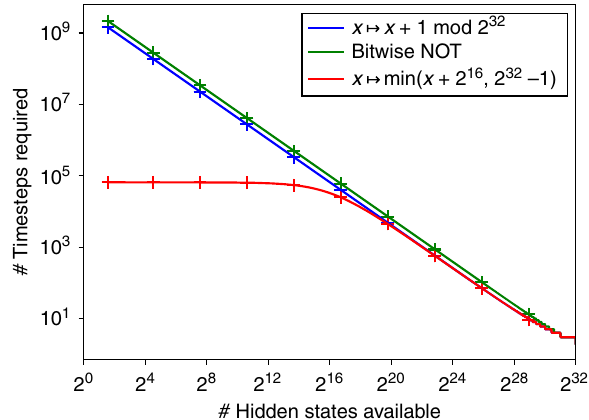
Fig. 1 The space/time tradeoff for three functions. The domain of all three functions is X ¼ f 0 ; ¼ ; 2 32 (cid:6) 1 g . Solid lines show exact results, crosses indicate the approximation given by Eq.